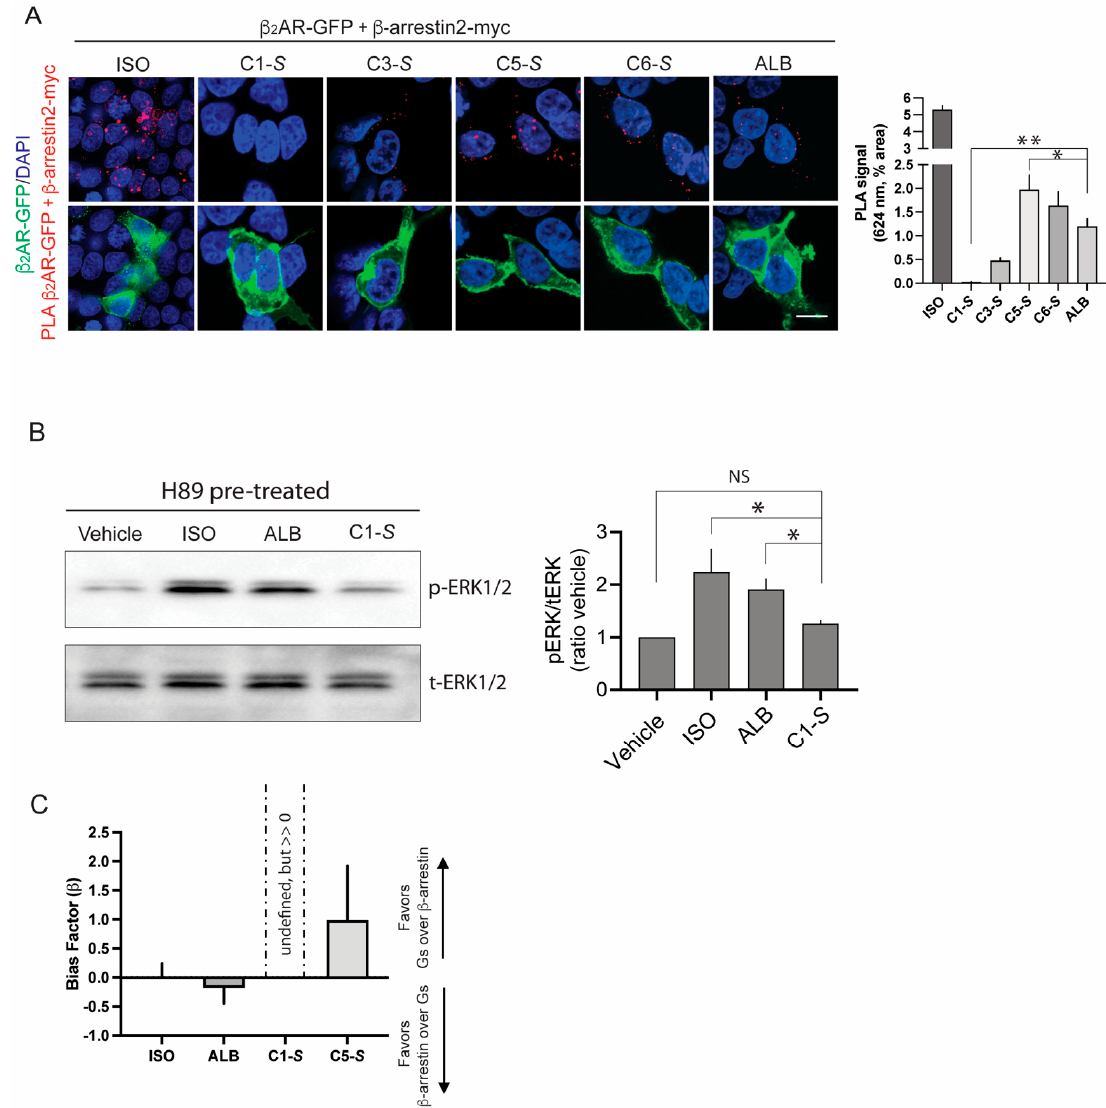
Figure 4. Biasing of C1-S away from β -arrestin. ( A ) Proximity ligation assay (PLA) in cells co- tranfected with tagged β 2 AR and β -arrestin2. In the representative confocal images, the red puncta indicate the agonist-promoted binding of β -arrestin2 to β 2 AR. The green signals are β 2 AR expressed on the cell surface, while the blue images are the nuclei stained with DAPI. The bar graph shows mean ± SE results from 5 independent experiments. C1-S at the highest concentration studied (300 μ M) failed to evoke a PLA signal; * p < 0.05, ** p < 0.001, the PLA signal is different from albuterol. These results were confirmed in enzyme complementation assays and β -arrestin recruitment assays [11]. ( B ) C1-S failed to activate (phosphorylate) ERK1/2 in human ASM cells. A representative gel and results from 5 independent experiments are shown. Studies were performed in the presence of the protein kinase A inhibitor H89 in order to isolate β -arrestin function. * p < 0.05 versus vehicle control; NS, not significant. ( C ) Bias factors for the indicated agonists. The results from Gs-coupling and β -arrestin binding experiments were used to calculate the bias factor [35]. The results are shown as mean ±95% confidence intervals from 4 experiments. ISO, ALB, and C5-S had values of ~0 (or the confidence intervals crossed 0) and were considered balanced, in agreement with studies by others